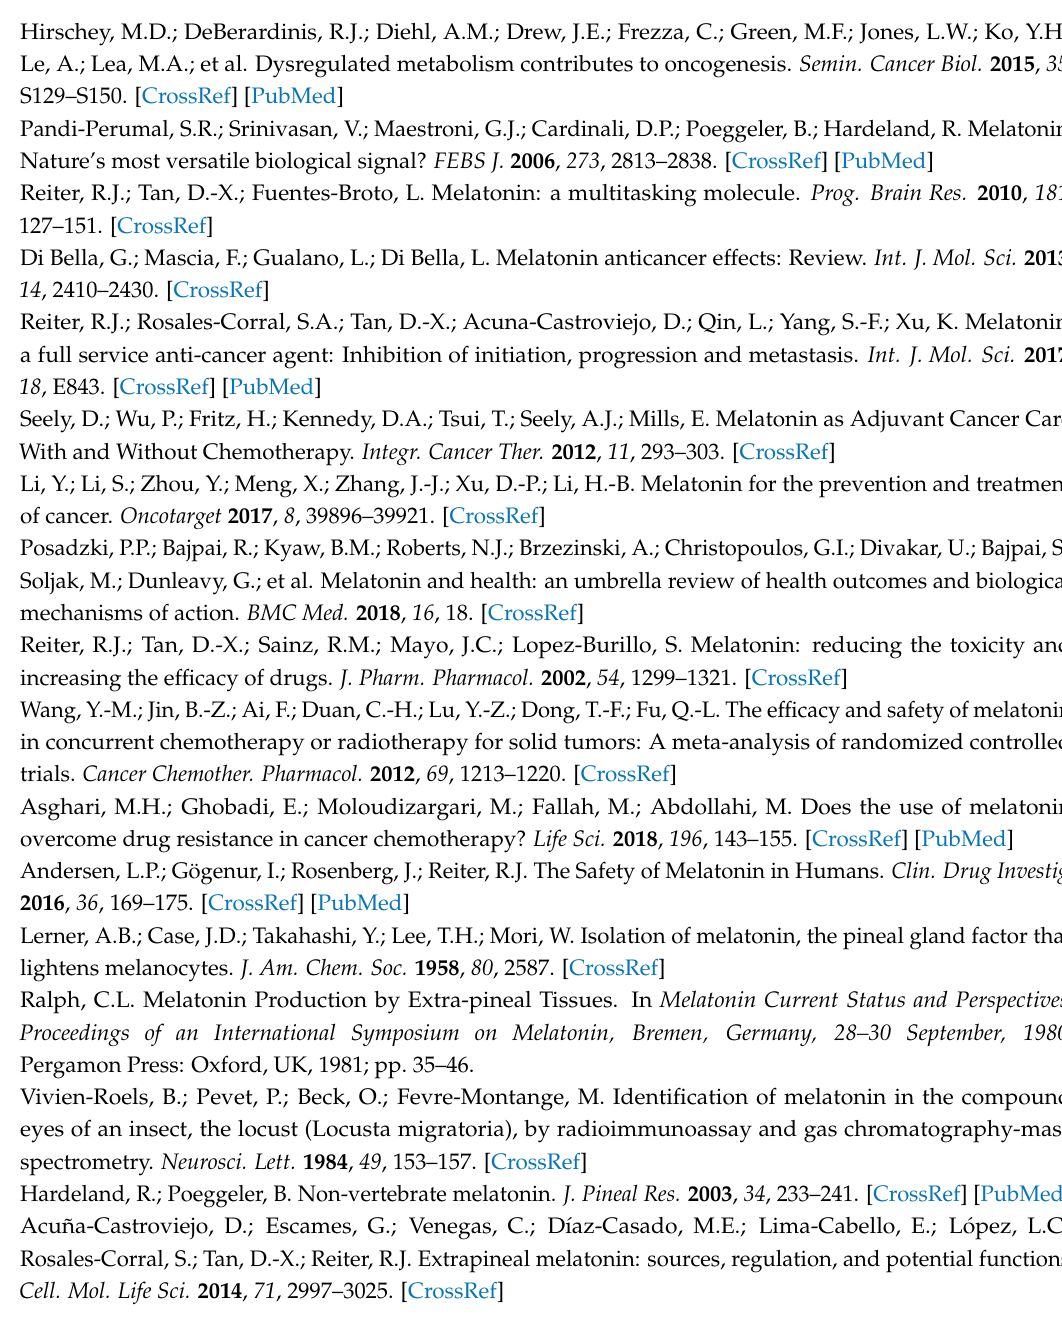
s1, Table S1: Oncostatic effects of MEL added to treatment with chosen pleiotropic drugs/chemotherapeutics in vivo and in human